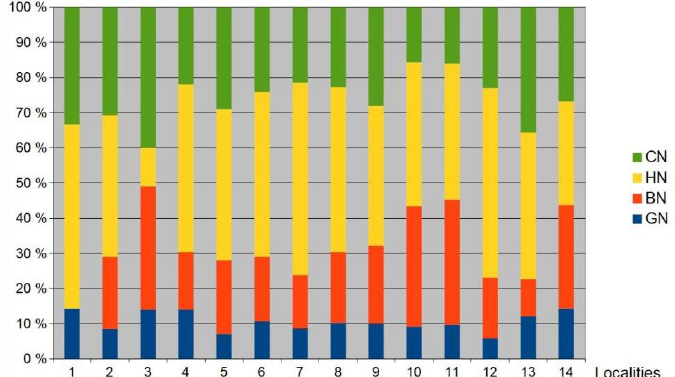
Figure 5. Comparison of guild structures in bird communities in the hardwood floodplain forests in the Czech Republic. (GN—ground nesters, CN—canopy nesters, HN—hole nesters, BN—bush nesters). Localities: 1 = average data from LPPLA, 2 = [41], 3 = [42], 4 = [44], 5 = [45], 6 = [46] Bosin, 7 = [46] Dubno, 8 = [46] Choltice, 9 = [46] Zbytka, 10 = [48] Sargoun, 11 = [48] Vrapac, 12 = [49], 13 = [49], 14 = [54]).